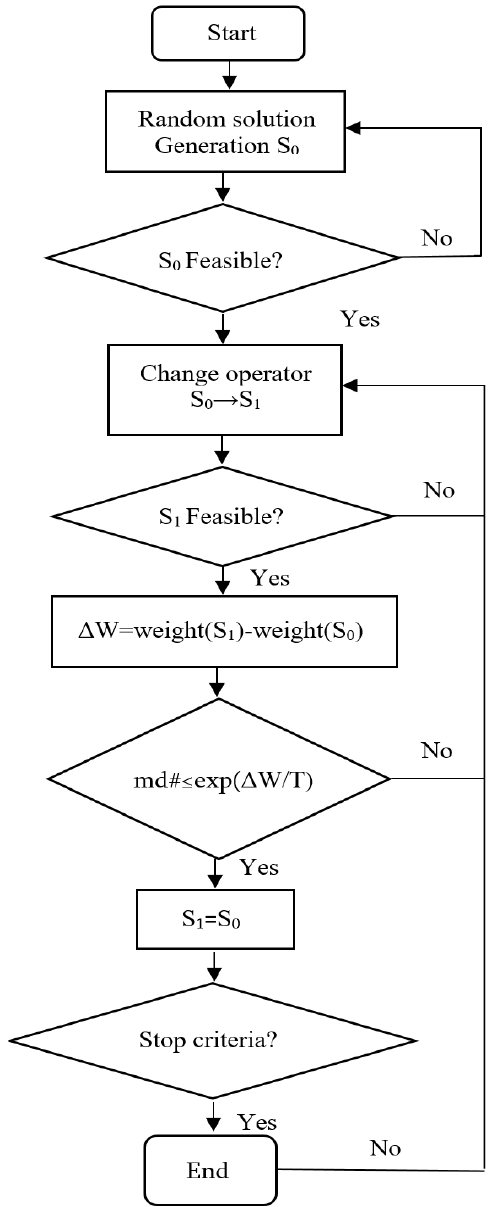
Figure 7. Flow chart of the optimization of the prestressed arched truss.